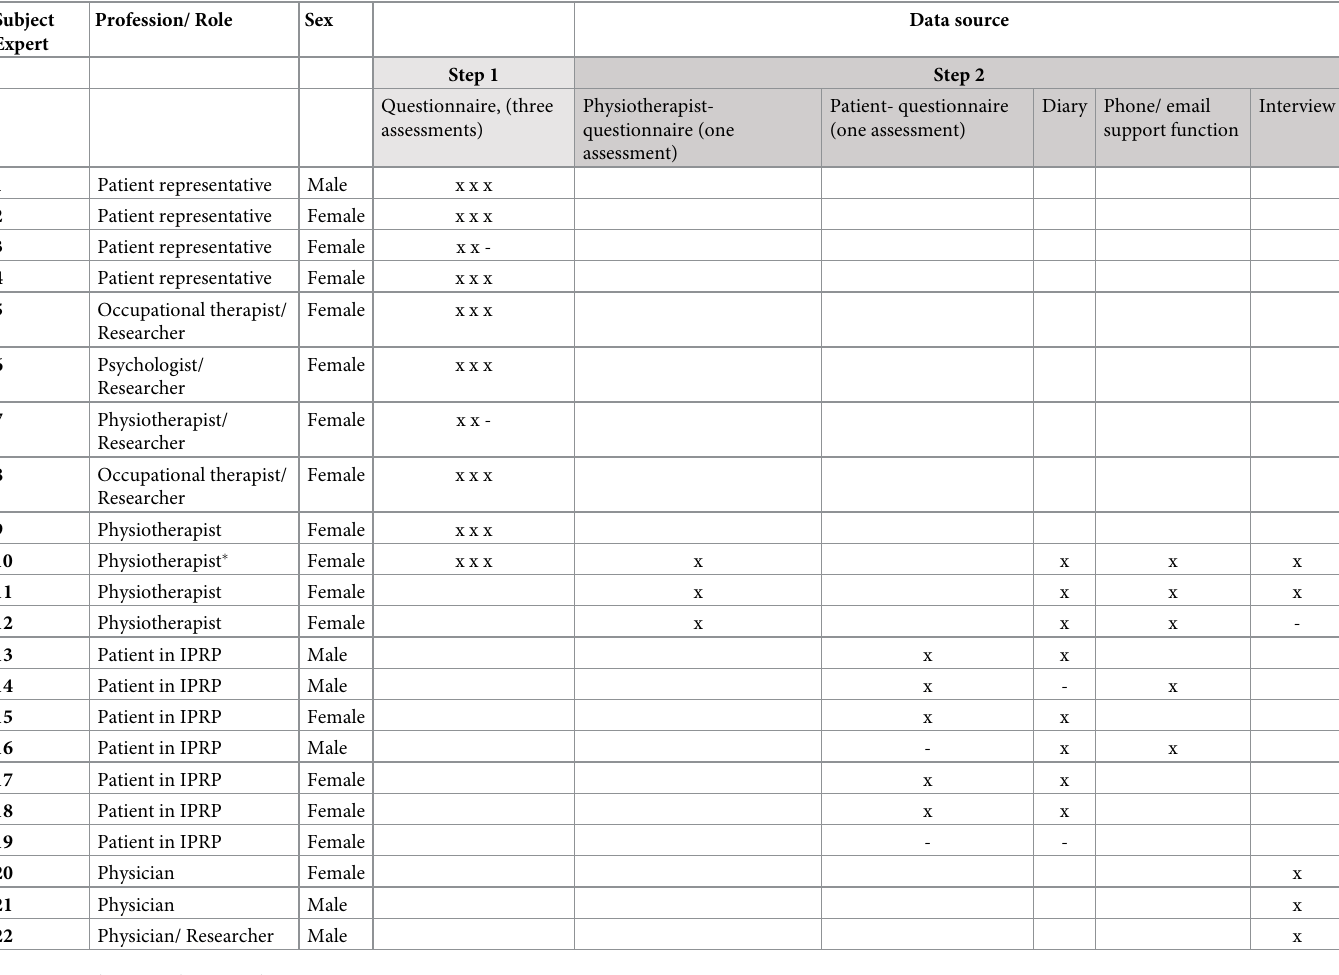
Table 1. Overview of participating subject experts per assessment round and data sources in Step 1 and Step